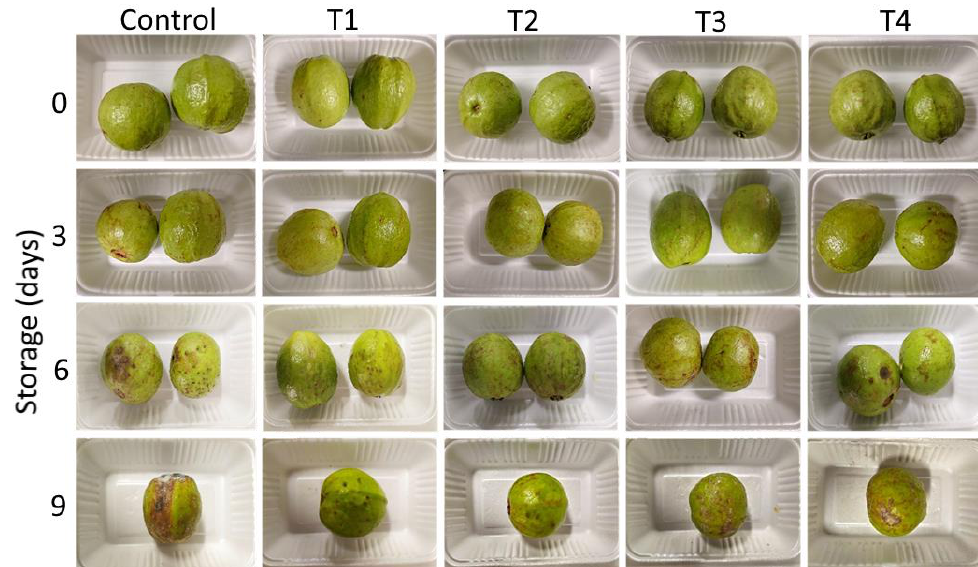
Figure 7. Visual appearance of guava fruits with or without an edible coating after 0, 3, 6, and 9 days of storage at room temperature. For sample codes, refer to Table